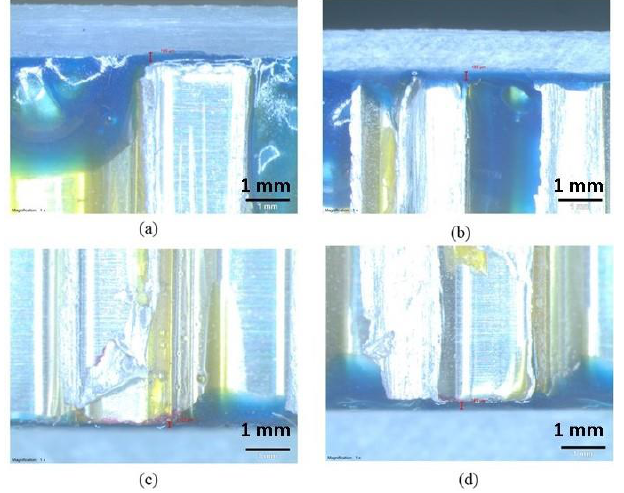
Figure 5. High-density honeycomb (HDHC) face sheet/core interface: ( a ) and ( b ) show the top face sheet/core interface at two different locations; ( c ) and ( d ) show the bottom face sheet/core interface at two different locations.